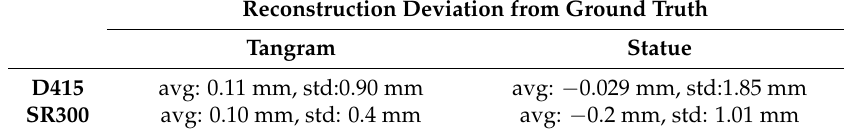
Table 7. The average deviation (avg) and standard deviation (std) from the ground truth data obtained for the 3D reconstruction of the two artifacts for D415 and SR300